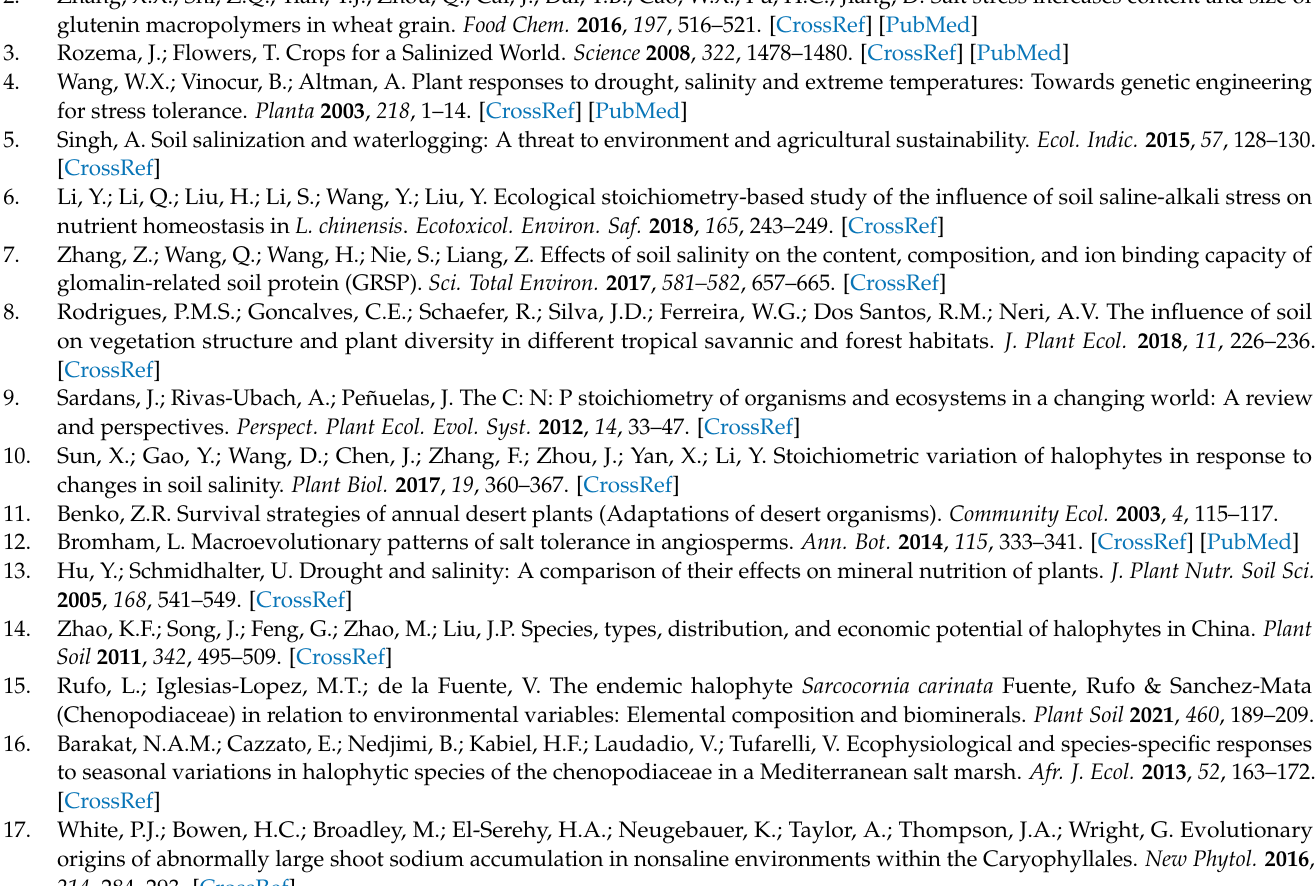
Table S2. Summary of the general linear models for the effects of salt tolerance type, salt, and soil mineral element factors on concentrations of mineral elements in